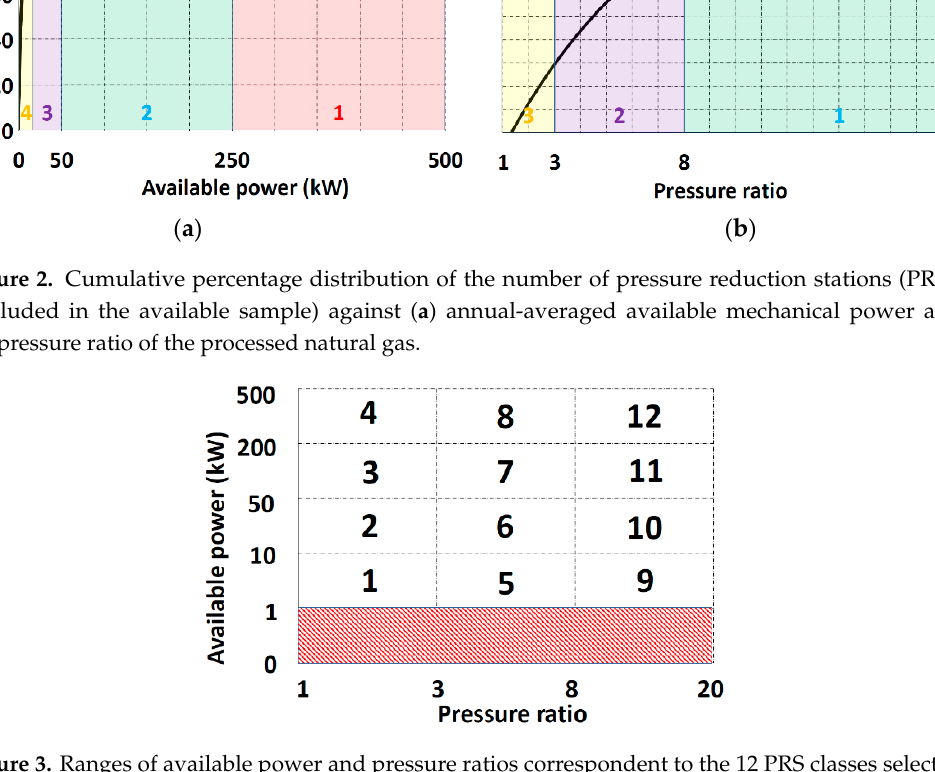
Figure 3. Ranges of available power and pressure ratios correspondent to the 12 PRS classes selected for economic and thermodynamic analysis.